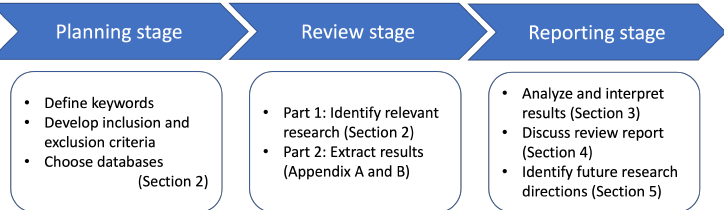
Figure 4. Three-stage procedure for systematic literature review. Source : Adapted from